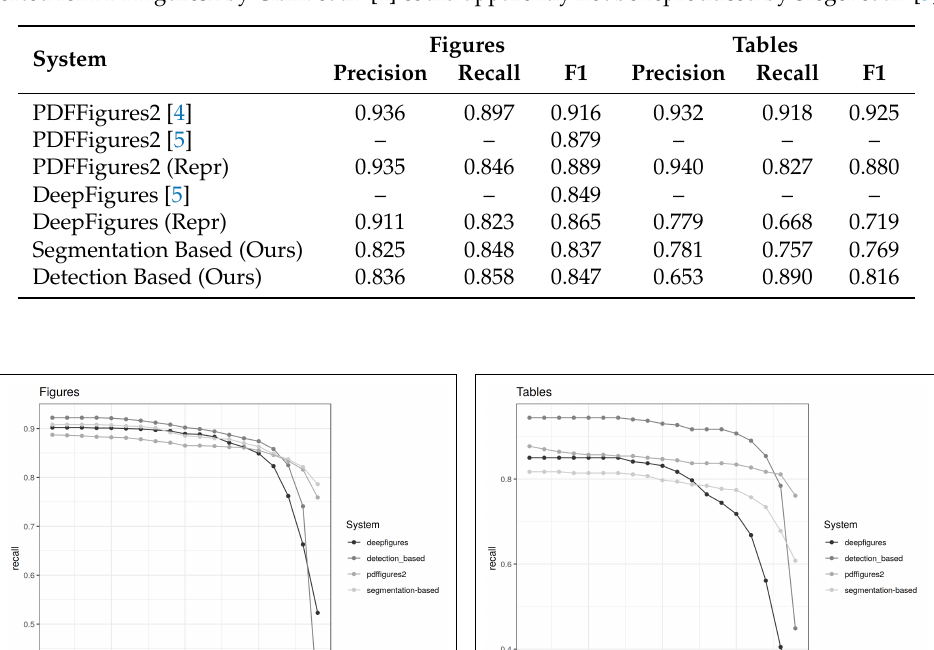
Table 2. Results of running the evaluation on the CS-Large corpus. Note that the very good results reported for PDFFigures2 by Clark et al. [4] could apparently not be reproduced by Siegel et al. [5].